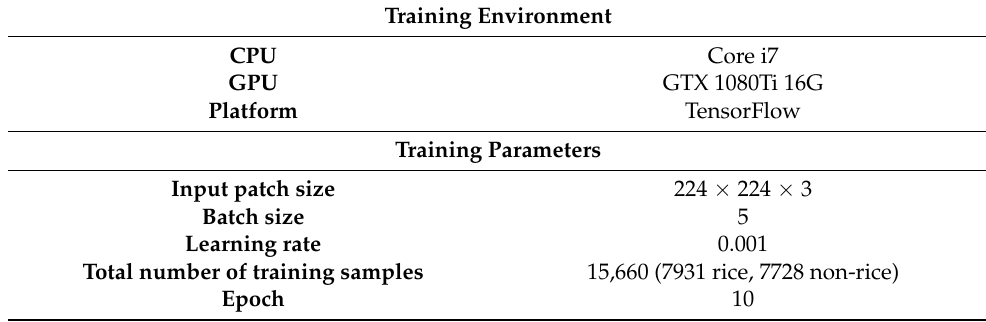
Table 3. Details of model